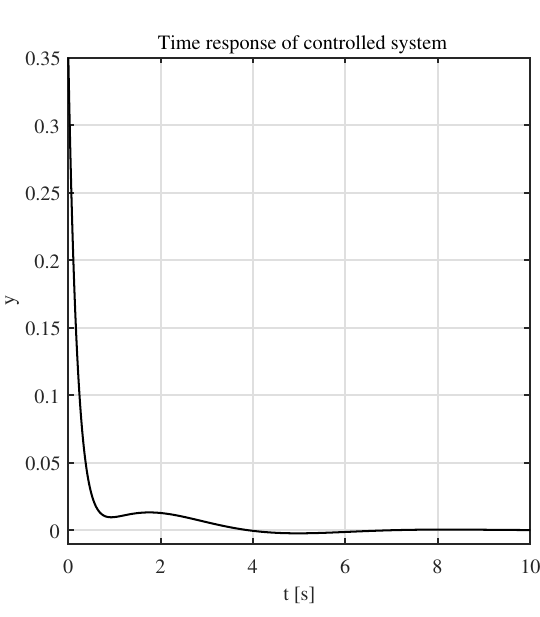
Figure 6: Time response of the controlled output variable.